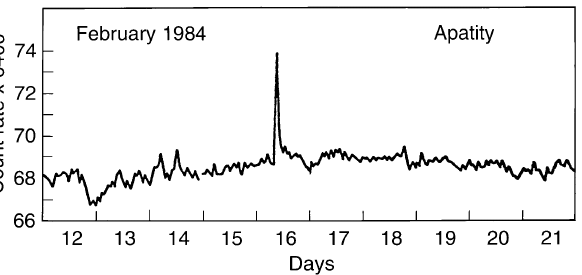
Fig. 1. Hourly count rates of the neutron monitor at Apatity ob- servatory from 12 to 21 February 1984